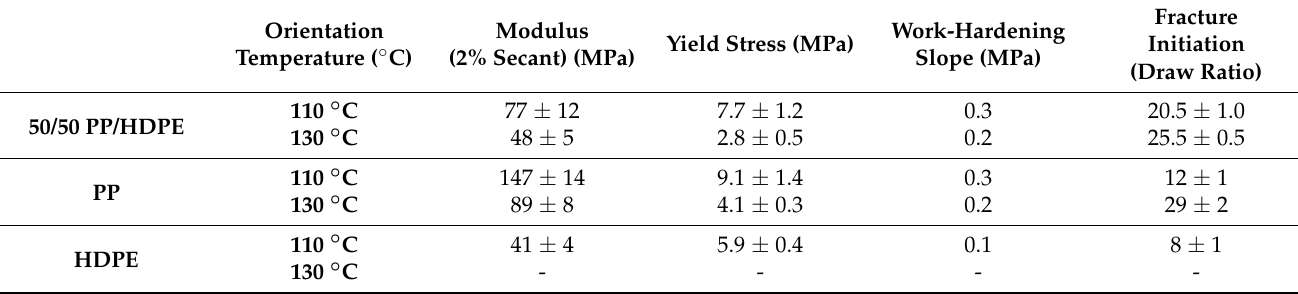
Table 1. Analysis of stress–strain tests during high-temperature orientation. The mean and standard deviation data are based on the average of three